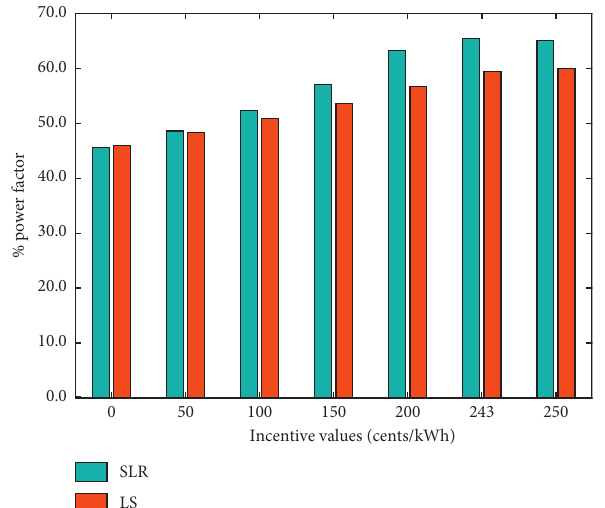
Figure 12: Percentage power factor after implementation of LS and SLR DSM